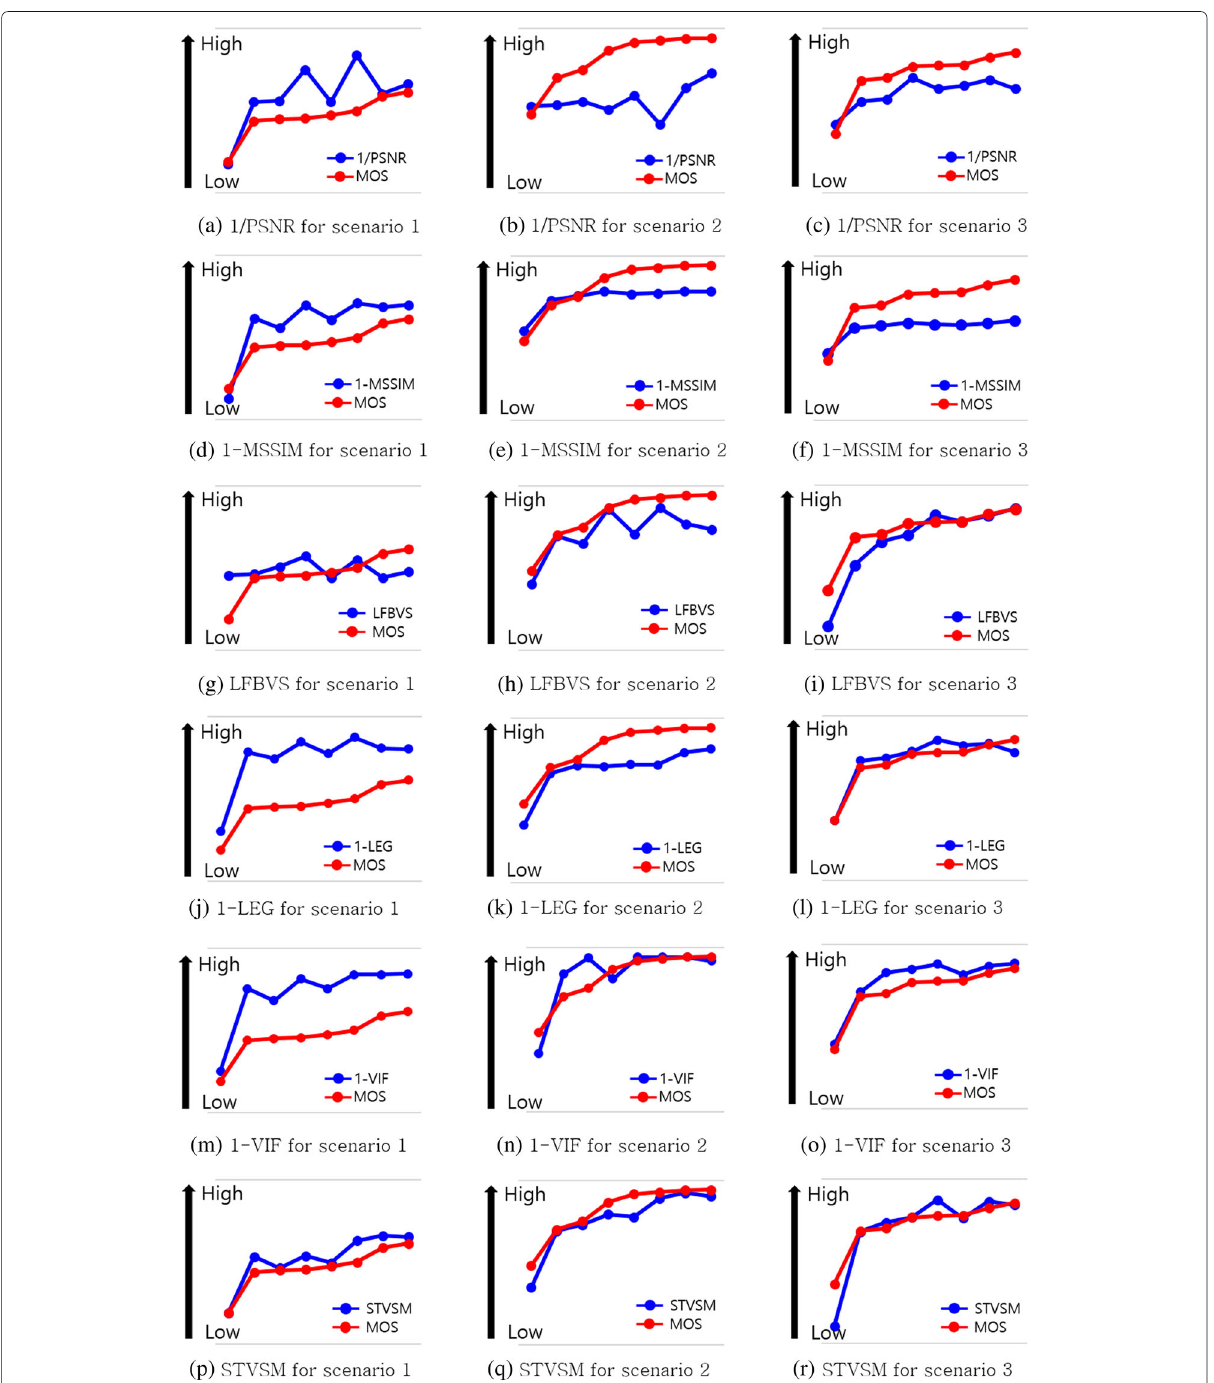
Fig. 3 Visual security evaluation results of objective (blue) and subjective (red) metrics for scenarios 1, 2, and 3 (from the subfigure ( a ) to ( r ) in case of Foreman video, x -axis represents different encryptions which result in different MOS in the increasing order and y -axis represents visual security). This figure shows the evaluation results from the objective metrics (PSNR, MSSIM, LFBVS, LEG, VIF, and STVSM) and the subjective scores of 66 subjects for various encrypted videos. From the subfigure ( a ) to ( r ) in case of Foreman video, x -axis represents different encryptions which result in different MOS in the increasing order and y -axis represents visual security. Figure 3 aims to present how each objective metric correlates with the subjective scores from the human eye’s